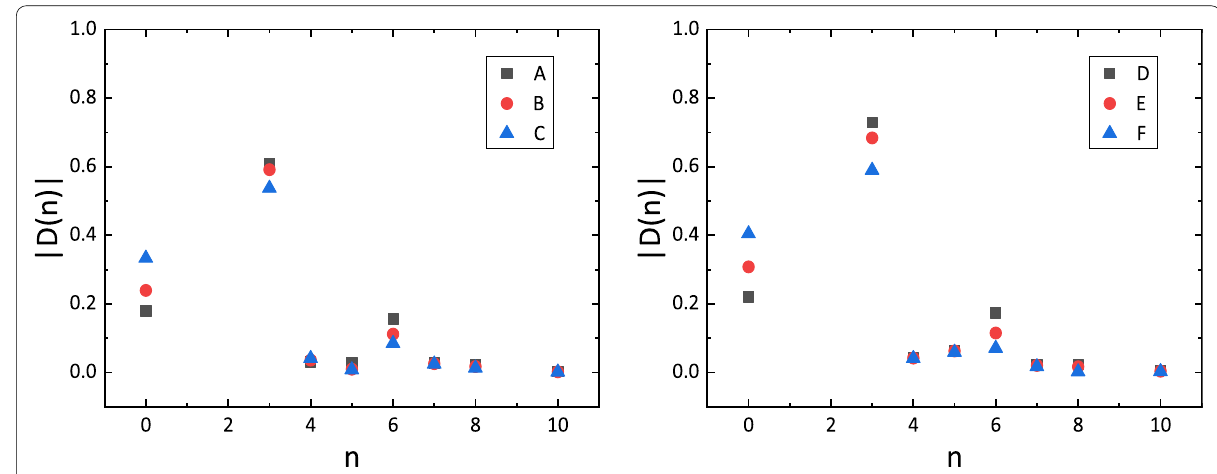
Fig. 1 The absolute values of the contributions of the vacuum condensates, where the A , B , C , D , E , and F denote the D ¯ D , D ¯ D s , D s ¯ D s , D D , DD s , and D s D s molecular states,